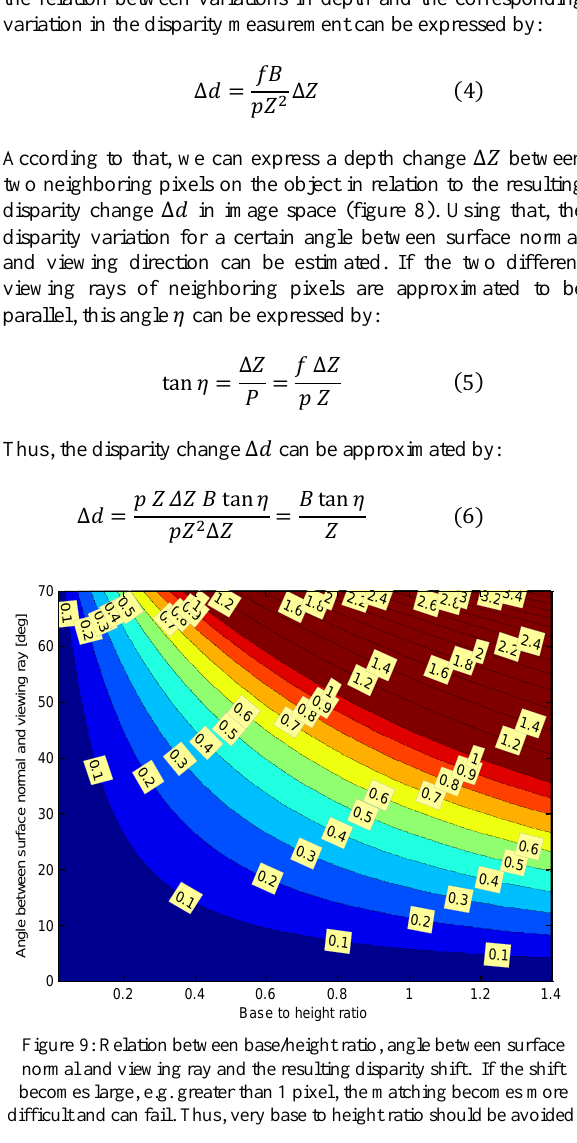
Thus, the relation base-to height ratio, surface normal and the